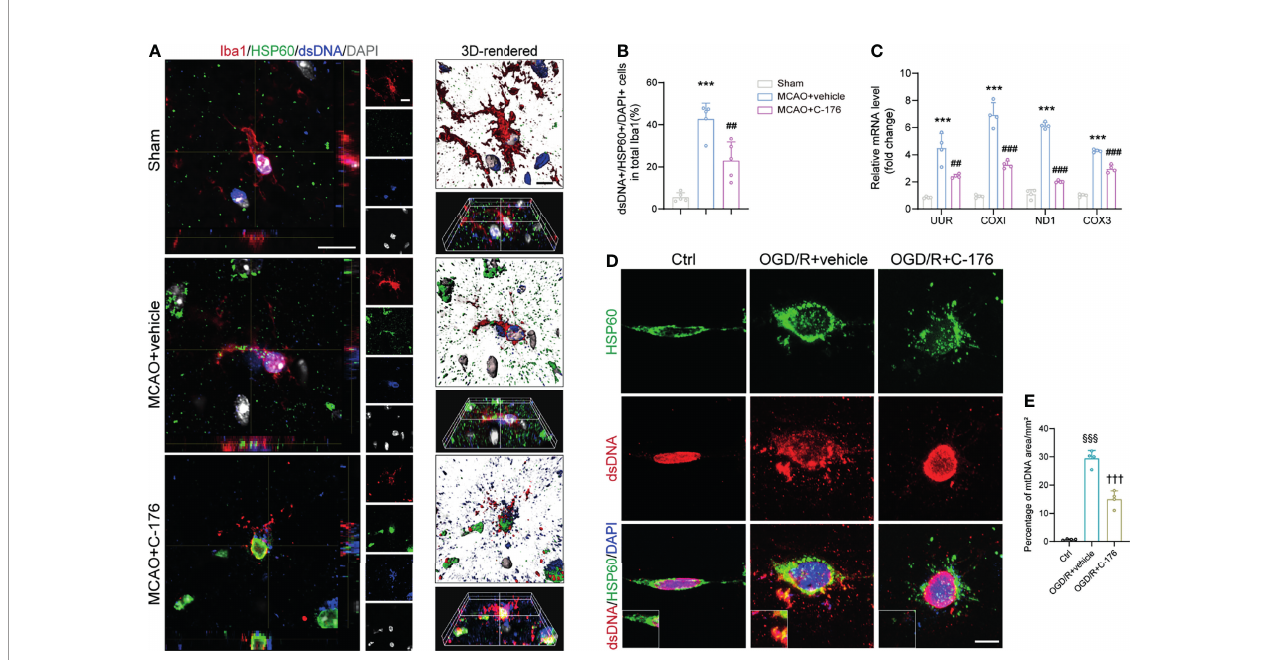
FIGURE 6 | Blockade of STING suppressed microglial mtDNA leakage after MCAO. (A, B) Representative confocal, 3D-reconstructed images of dsDNA + /HSP60 + / Iba1 + microglia and quanti fi cation of microglial mtDNA 1d post-MCAO. Images were reconstructed from confocal images using Imaris software. n = 5. (C) Relative mRNA expression of mtDNA-speci fi c genes (UUR, COXI, ND1 and COX3) 1d after MCAO. n = 4. (D, E) BV2 microglia cells were stained with anti-dsDNA and anti- HSP60 to detect mtDNA at 24h after reoxygenation. Representative dsDNA/HSP60 double immunostaining images and quanti fi cation of mtDNA. n = 4. Data are expressed as means ± SD. *** P < 0.001 vs Sham group; ## P < 0.01, ### P < 0.001 vs MCAO+vehicle. §§§ P < 0.001 vs Ctrl group; ††† P < 0.001 vs OGD/R+vehicle group. Scale bar = 10 m